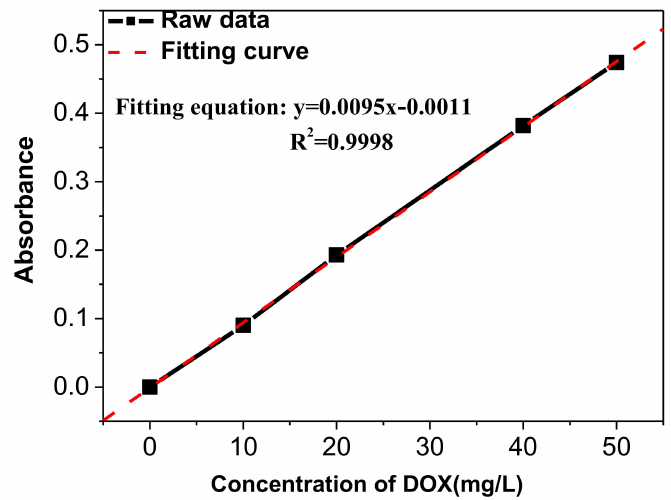
Figure 7. UV absorption standard curve of